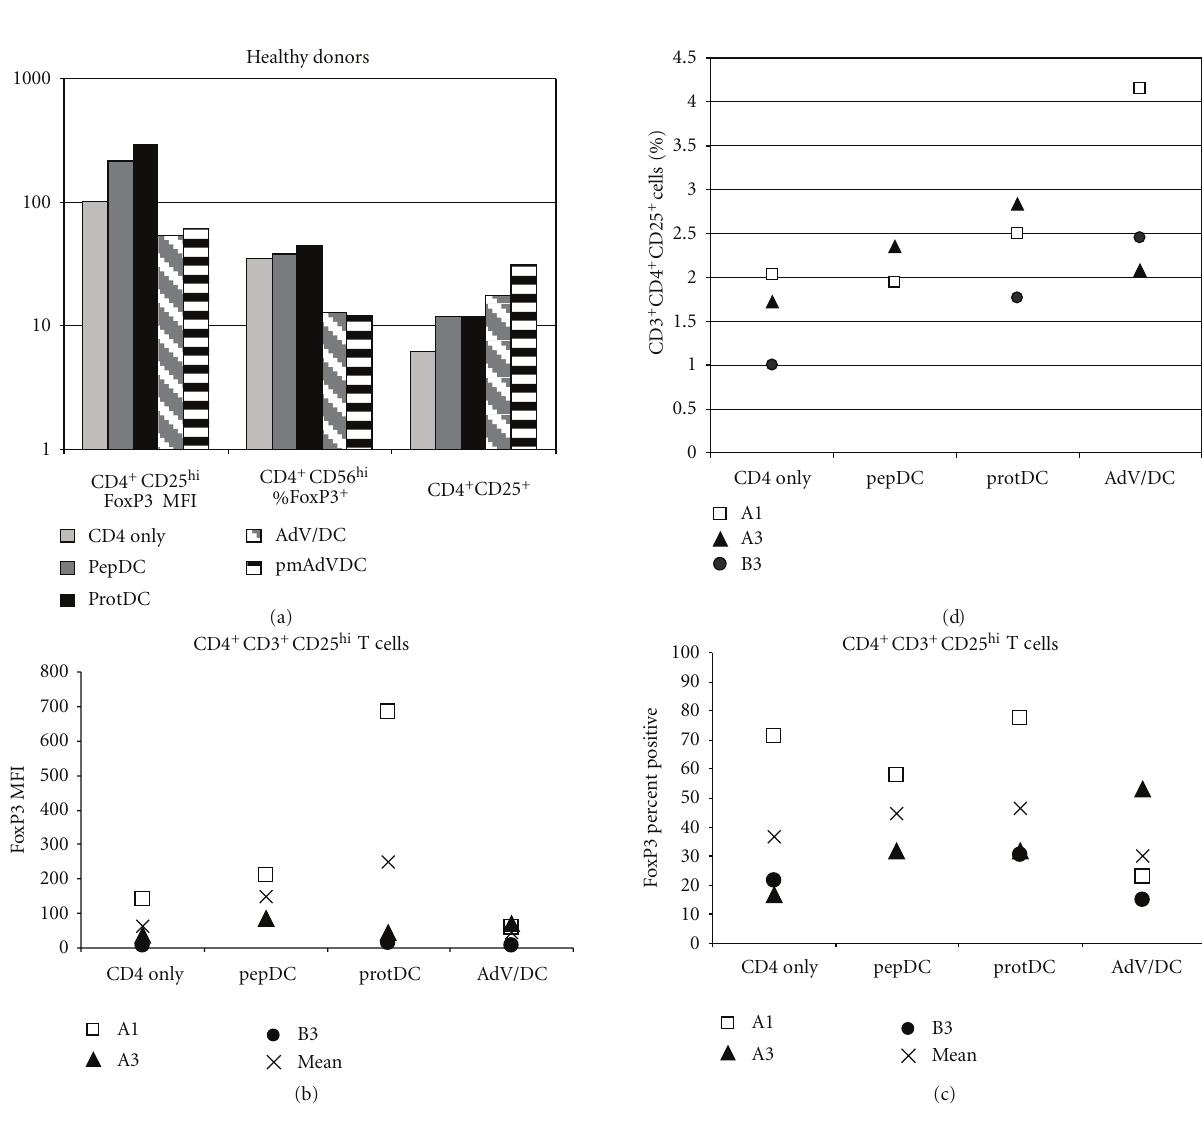
Figure 5: Treg cell responses to DC coculture. HD (a) and HCC patient (b, c, and d) CD4 + T cells were cocultured with di ff erentially treated DC. The FOXP3 expression in CD3 + /CD4 + /CD25 hi cells is shown in (a) as MFI (left), percent positive (middle). The right group is the frequency of total activated (CD25 + ) CD4 + T cells. The FOXP3 MFI in Treg in HCC patients is shown in (b). The percent CD3 + /CD4 + /CD25 hi /FOXP3 + Treg in HCC patients is shown in (c). The overall frequency of activated CD4 + T cells is shown in (d) (% CD3 + /CD4 + /CD25 +